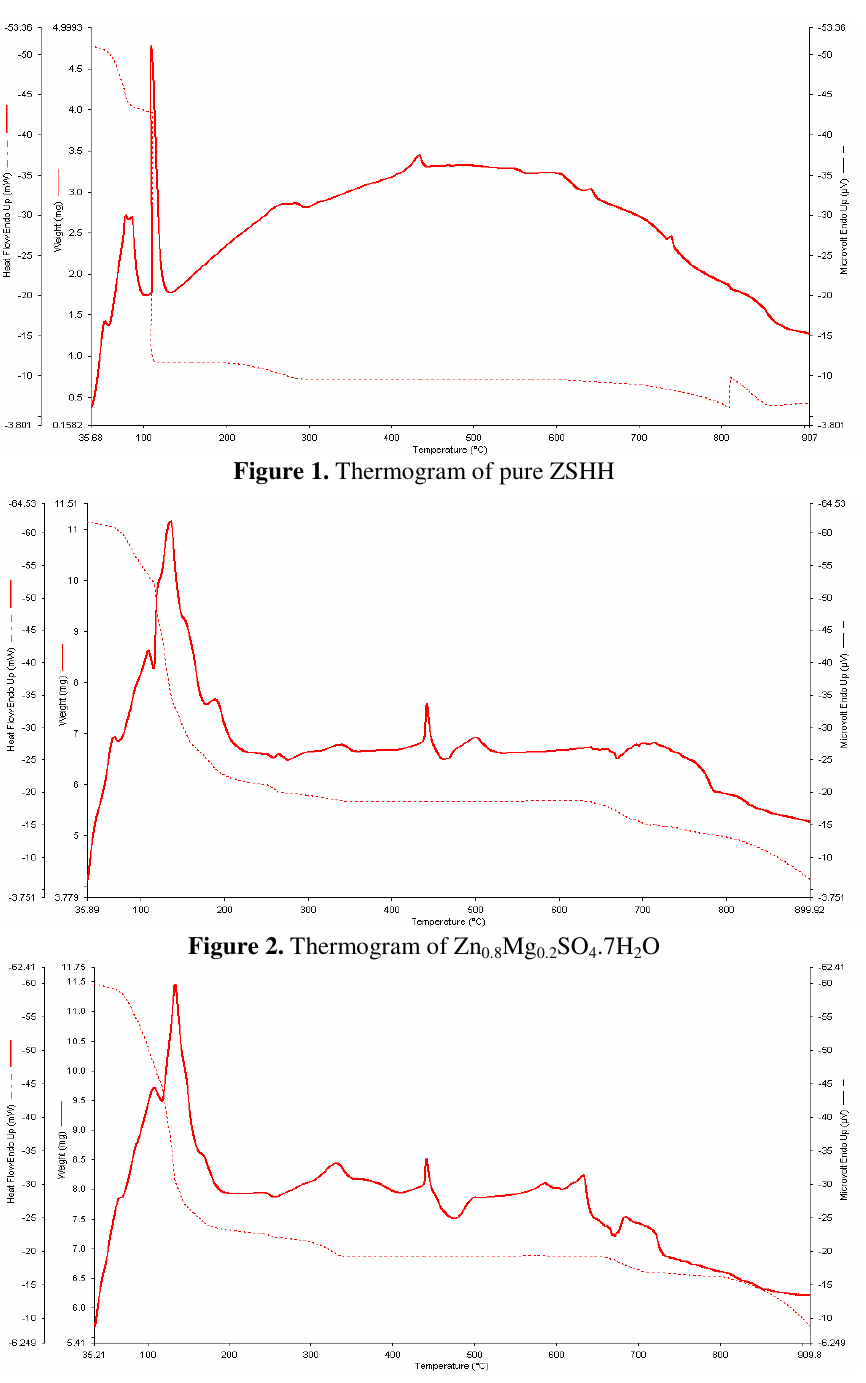
Figure 3. Thermogram of Zn